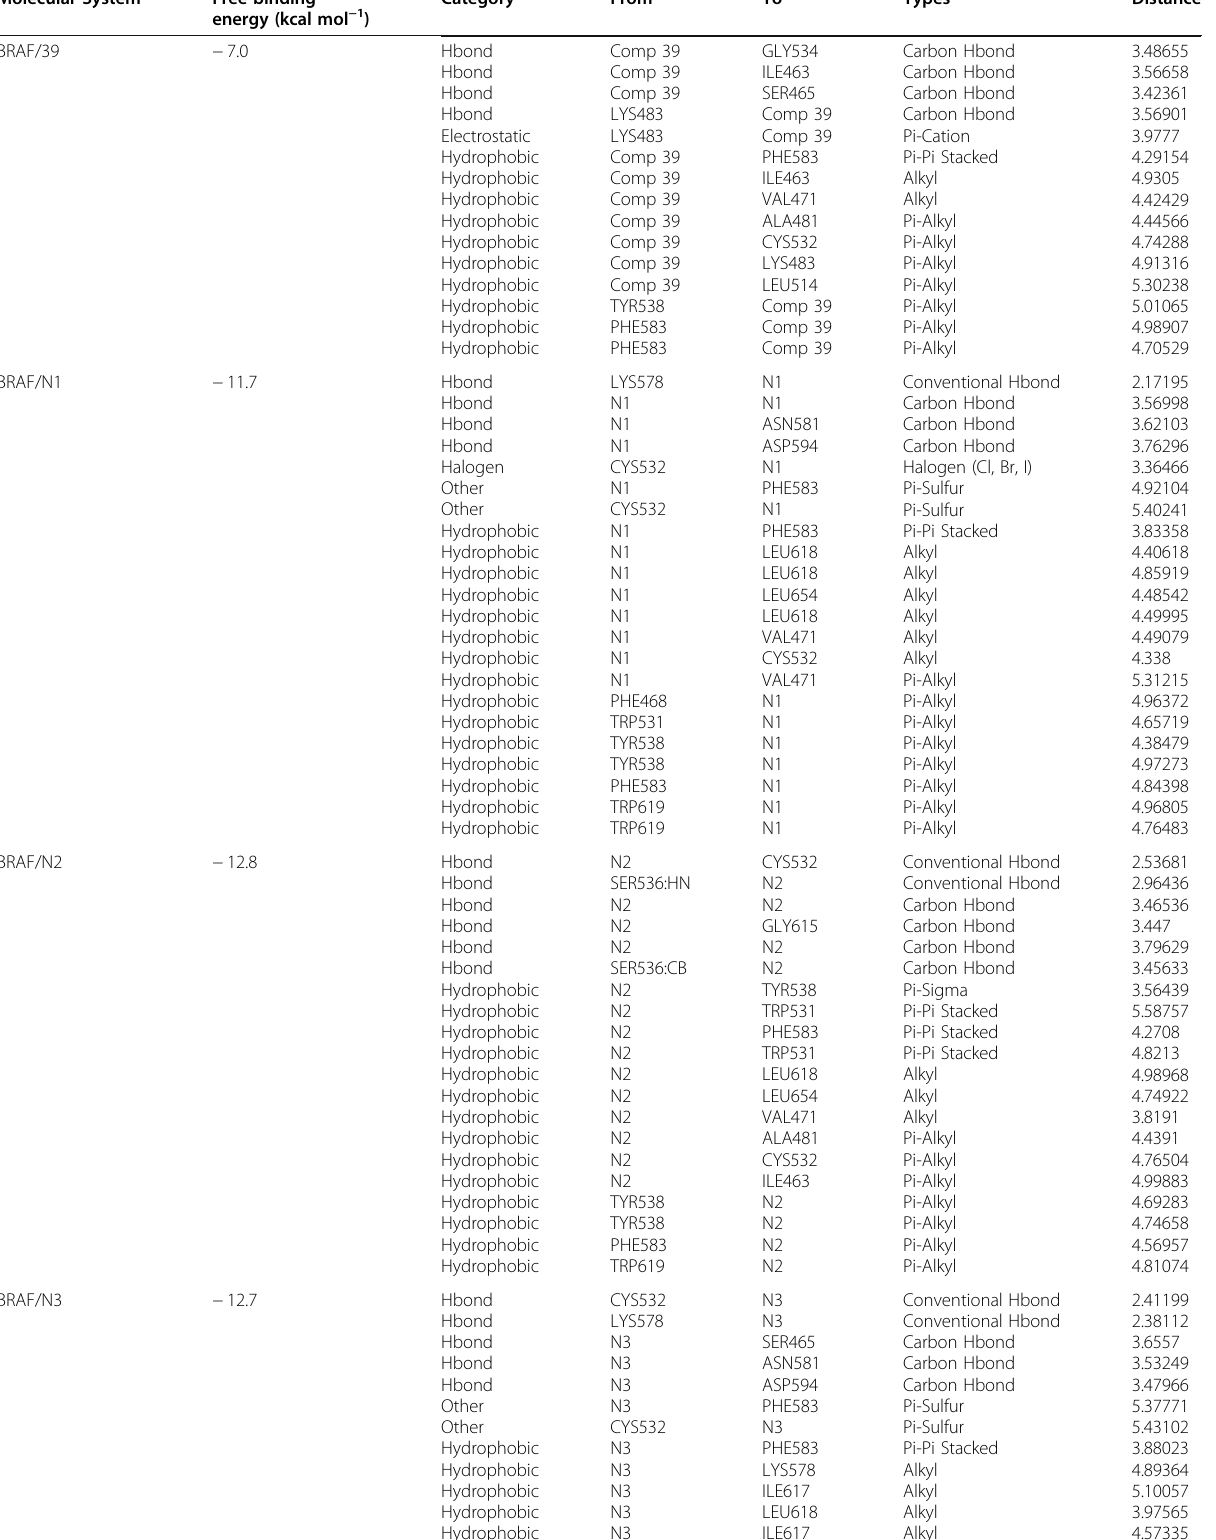
Table 3 Docking information for the interaction of designed compounds with V600E-BRAF (PDB ID: 3OG7) Molecular